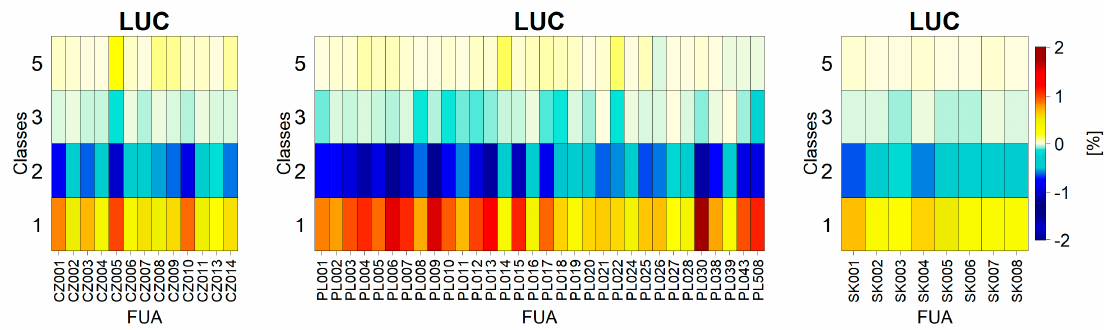
Figure 3. LUC in basic classes between 2006 and 2012 in Czechia, Poland, and Slovakia. The largest growth of urbanised areas at the expense of agricultural areas, semi-natural areas, and wetlands were identified in Czechia in CZ005 ( Ú st í nad Labem), in Poland for PL006 (Gda´nsk), PL009 (Lublin), and PL030 (Jastrz˛ebie Zdr ó j), and in Slovakia for SK001 (Bratislava). Capitals of Poland and Czechia also saw a significant increase in urbanised areas. Prague grew more urbanised by 0.82% (3928 ha), and Warsaw, by 0.81% (6616 ha). For Czech FUAs, class 1 areas on average grew by 0.57% of FUA CZ (9276 ha) in total, and class 2 on average shrunk by 0.57% of FUA CZ (9276 ha) (see Table 1). The most significant changes in class 1 and 2 areas took place in Poland. The area of class 1 on average grew by 0.81% of FUA PL (48,890 ha), and class 2 was on average reduced by 0.77% of FUA PL (46,476 ha) (see Table 1). The smallest changes in class 1 and 2 areas took place in Slovakia. The area of class 1 on average grew by 0.40% of FUA SK (3469 ha), and class 2 was on average reduced by 0.37% of FUA SK (3209 ha) (see Table 1). Moreover, the area of class 3, forest, grew smaller in Czechia by 0.03% of FUA CZ (514 ha), in Poland by 0.06% of FUA PL (3811 ha), and in Slovakia by 0.03% of FUA SK (280 ha). Table 1. Mean values of LUC in basic classes between 2006 and 2012 in Czechia, Poland, and Slovakia.